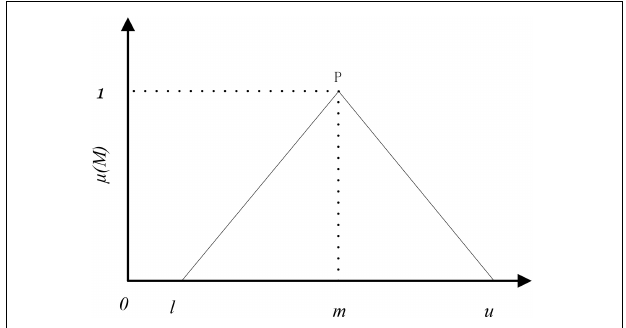
FIGURE 1 | Triangular fuzzy number (P).